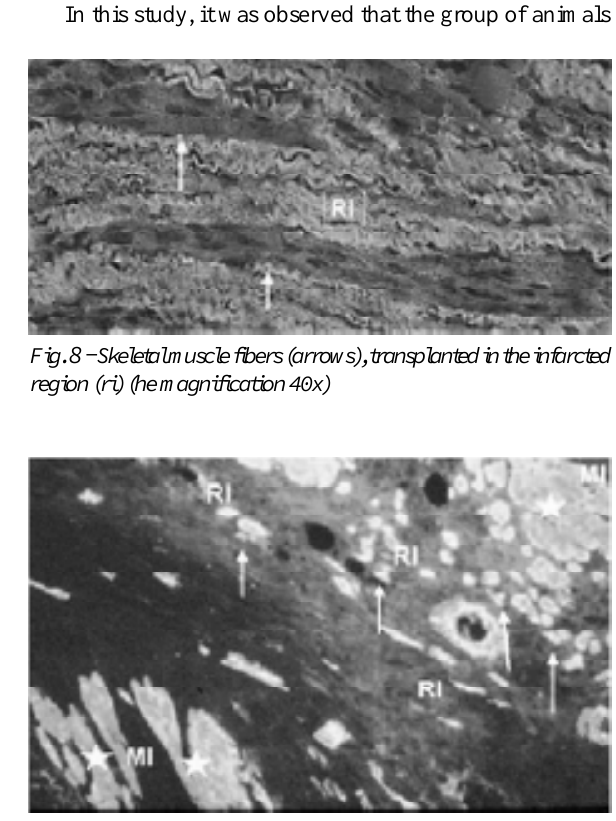
Fig. 9 - Immunofluorescence of desmin. Notice the viable muscle fibers (arrows and stars) in the infarcted region (ri) and in the integral myocardium (mi) (magnification 150x)